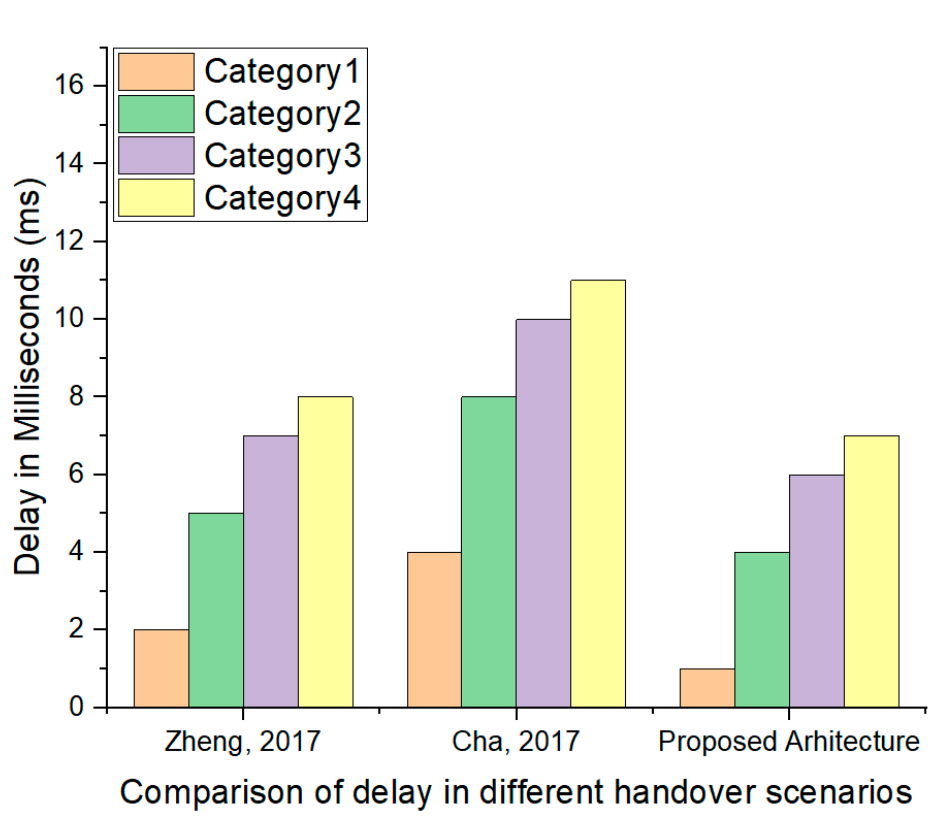
Figure 7. Comparison of the delay time with previous works [25] (Zheng, 2017) and [26] given by (Cha, 2017).